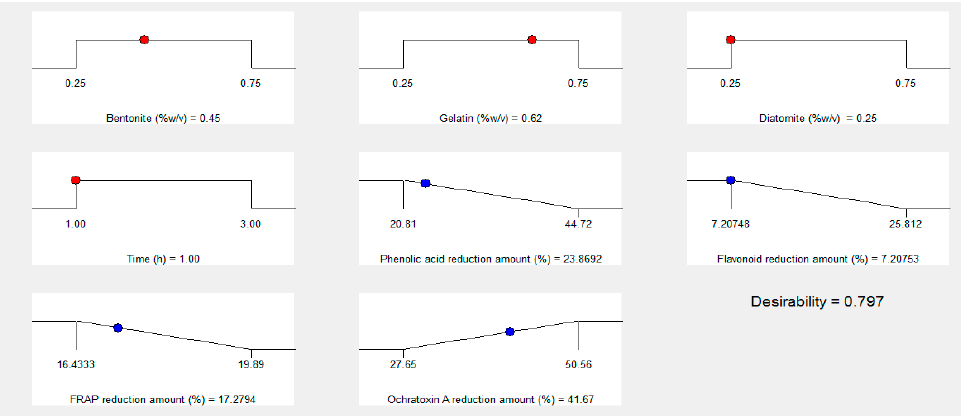
Figure 5. The optimum value of different variables for OTA removal of grape juice.